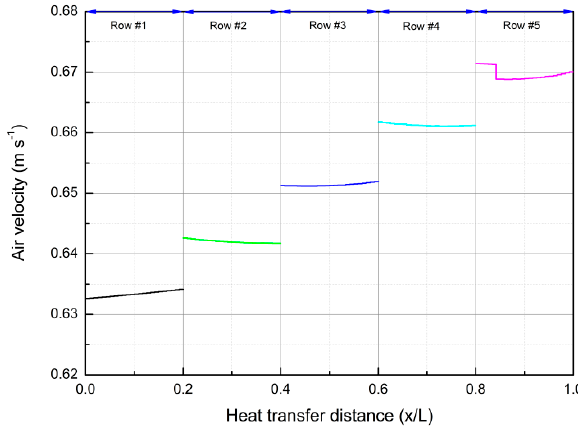
Figure 12. The air velocities through the heat exchanger bundles.